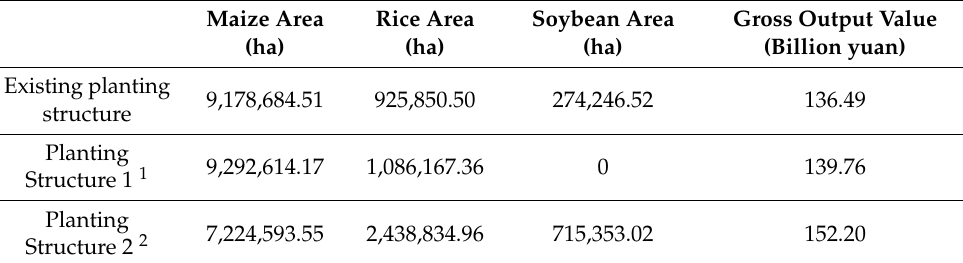
Table 8. Statistics for different planting structures.